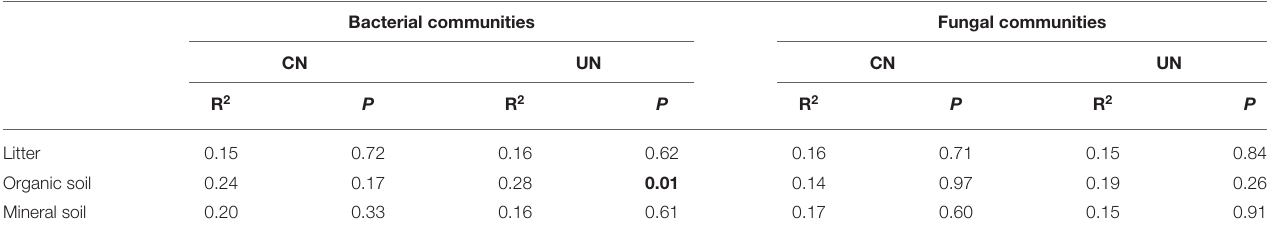
TABLE 1 | Effects of canopy N addition (CN) and understory N addition (UN) on bacterial and fungal community compositions at OTU level based on Bray–Curtis distance, as determined by PERMANOVA. Bacterial communities Fungal communities